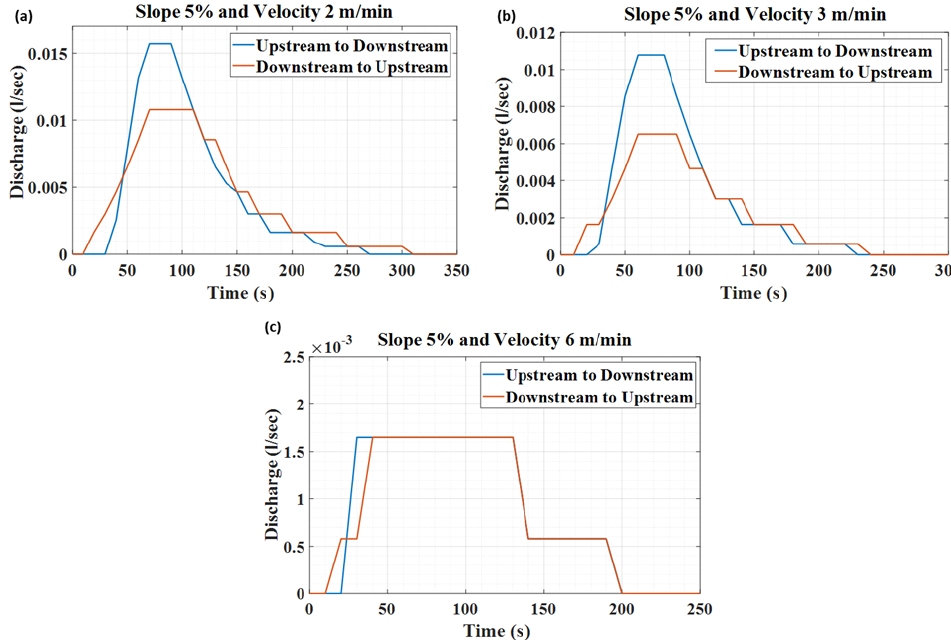
Figure 11. Hydrograph for velocity 2mmin − 1 (a) , 3mmin − 1 (b) , and 6mmin − 1 (c) at 5%